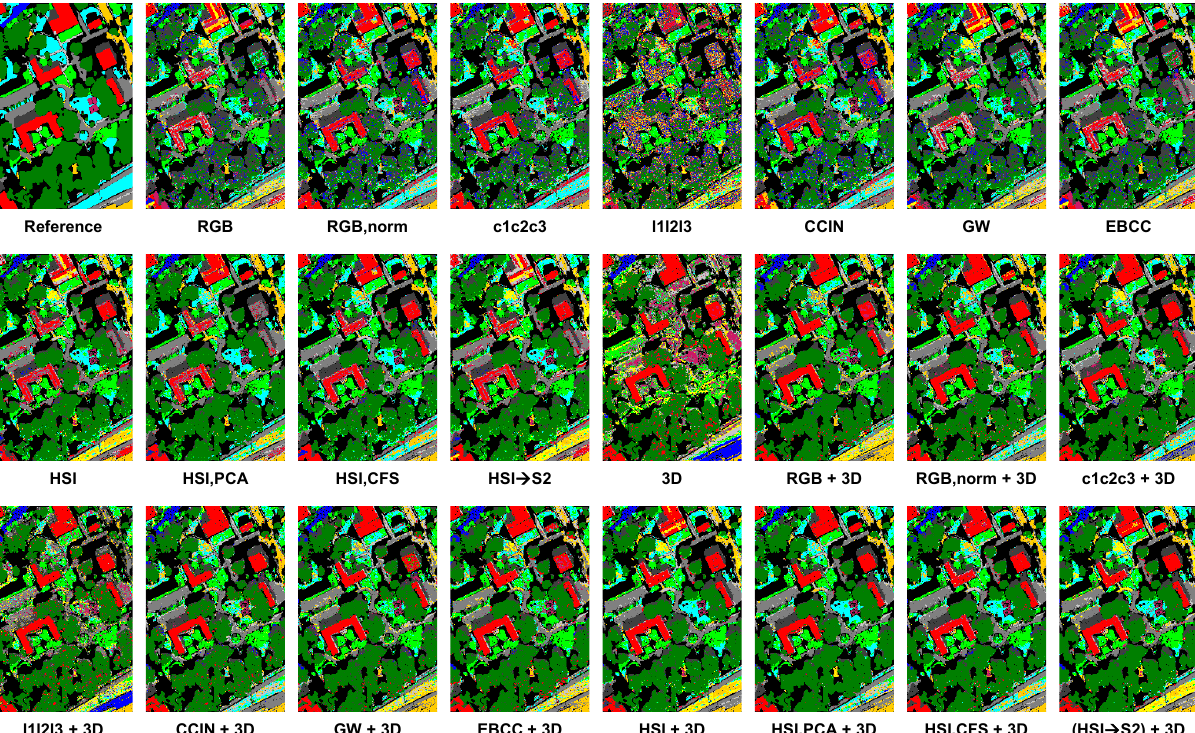
Figure 3. RGB color image, the corresponding LiDAR data represented digital surface model (DSM) and the given reference labeling with respect to 11 semantic classes as well as a further class for unlabeled data.